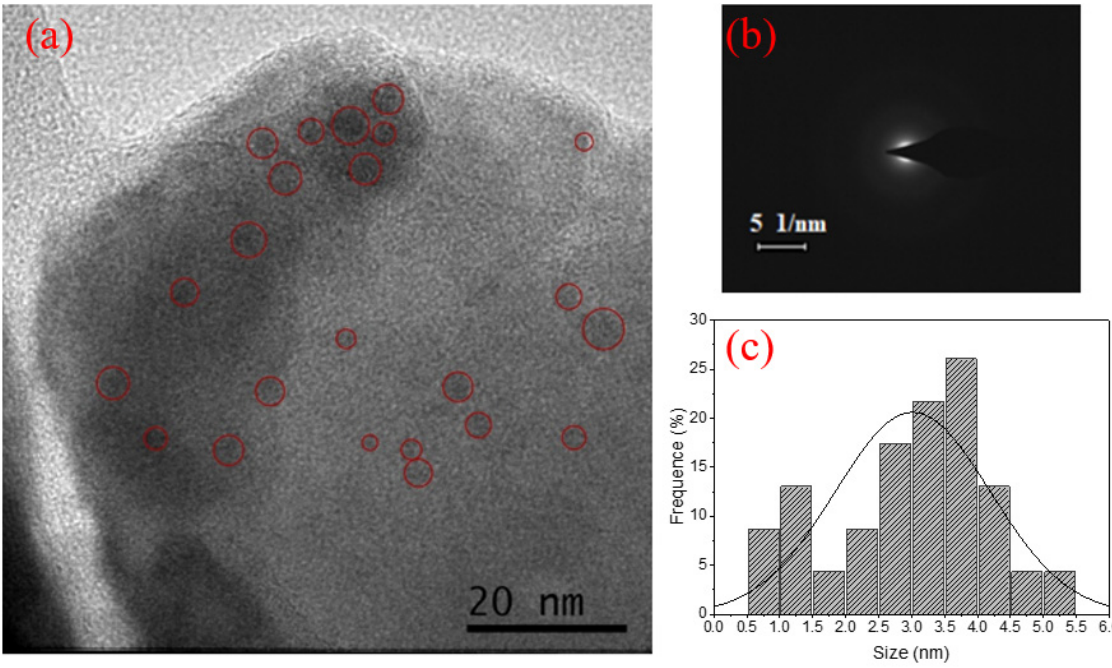
Figure 11. ( a ) TEM image of the GP 4.5Ag2Yb sample, ( b ) ED pattern, and ( c ) size distribution.